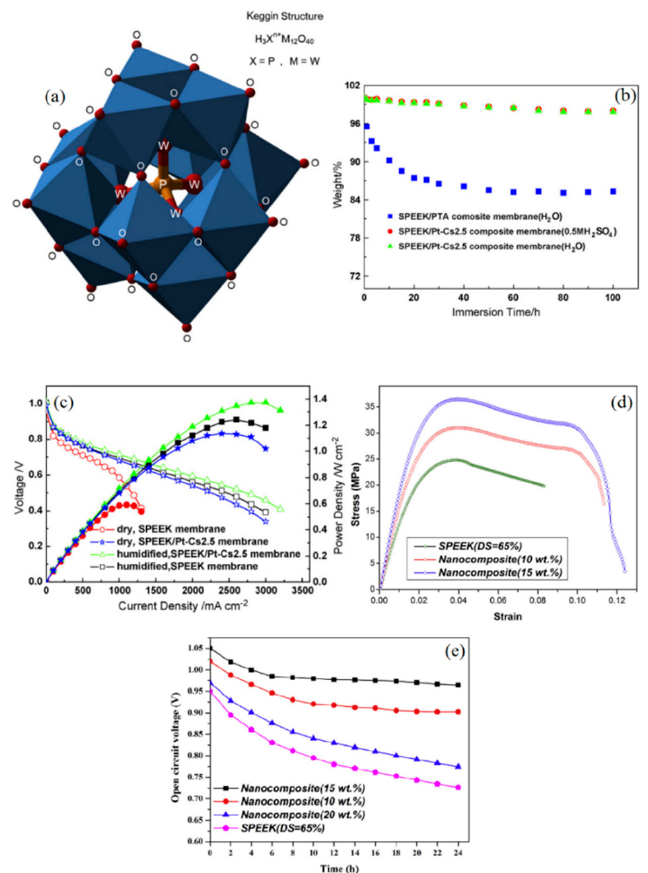
Figure 5. ( a ) Keggin structure of phosphotungstic acid (PTA) as a proton-conductor additive (reprinted with permission from [80]); ( b ) durability evaluation of PTA / SPEEK and Pt–Cs 2.5 / SPEEK in aqueous and acidic environment and ( c ) PEFC performance of plain and nanocomposite SPEEK membranes at 60 °C (reprinted with permission from [77]); ( d ) stress–strain curves for additive-free and Pt–Cs 2.5 / SPEEK PEMs and ( e ) open circuit voltage (OCV) test for the stability measurement